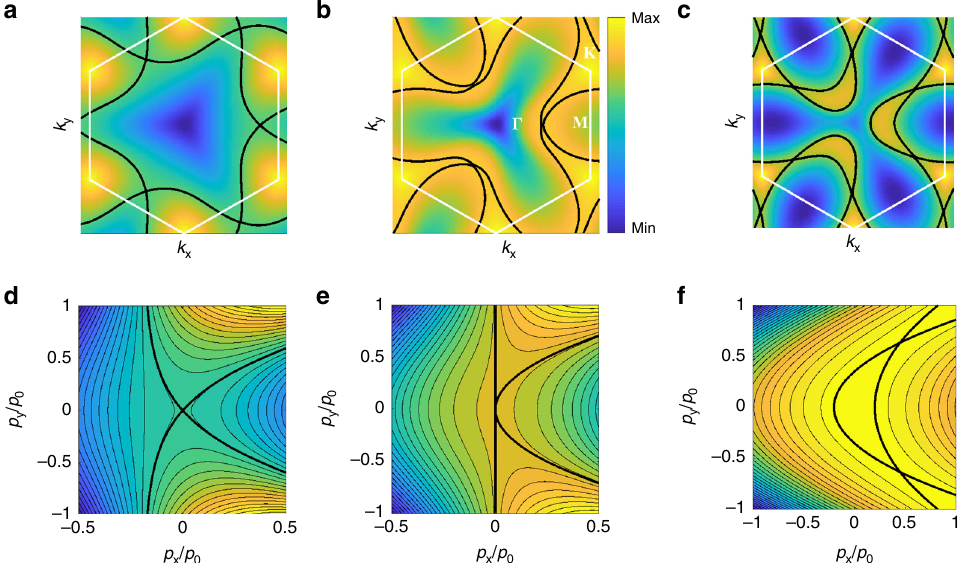
Fig. 2 Energy contours during the topological transition of van Hove singularity (VHS). Energy contours from band structure calculation are shown in a – c and from the polynomial expansion around saddle point (3) in d – f . Thick lines are energy contours at VHS energy. In band structure calculation, g 0 ¼ 1 : 2 g and the parameters are a g ¼ 1, b g ¼ 1 : 9, and c g ¼ 2. In d – f , p 0 ¼ α = ~ γ and the parameters are d β ¼ 0 : 2 α ; κ ¼ 0, e β ¼ 0 ; κ ¼ 0, and f β ¼ (cid:4)